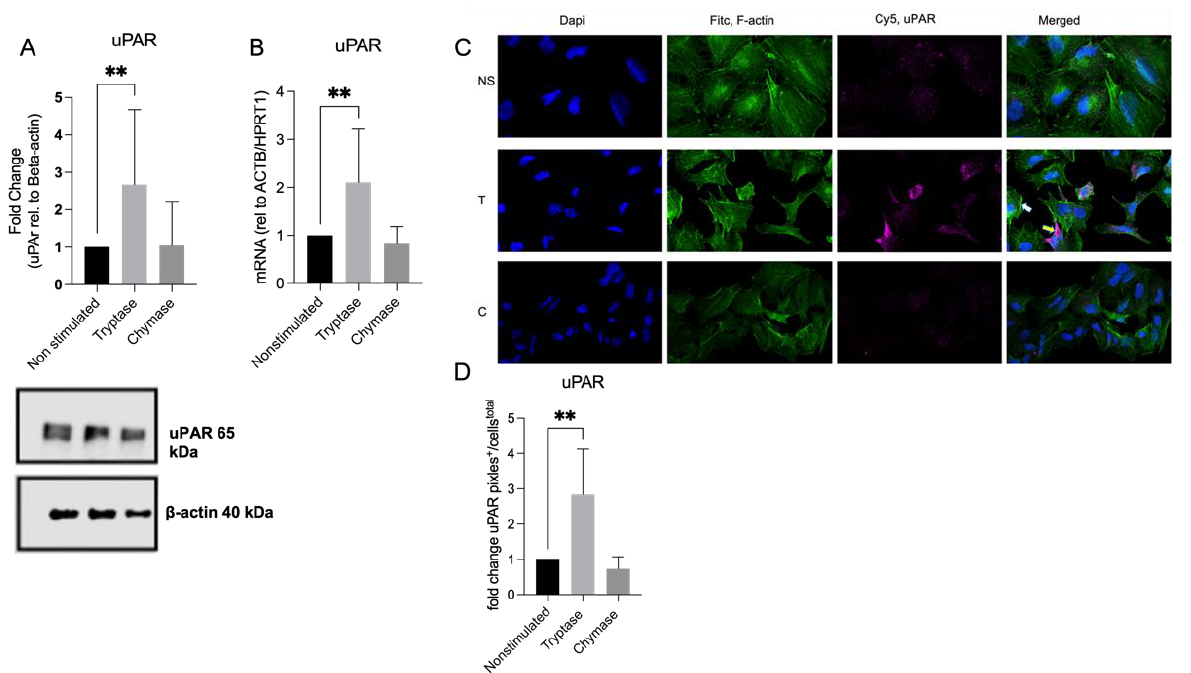
Figure 3. Cell lysates analyzed with Western blot and results based on quantification of fold change. Tryptase stimulated cells augmented the expression of uPAR (65 kDA) on protein level compared to non-stimulated cells ( A ). Tryptase stimulated cells enhanced the expression of uPAR on gene level ( B ). Double staining visualized with confocal microscopy of alveolar epithelial cells targeting F-actin (FITC/green) and uPAR (Cy5/Purple) revealed a stronger signal of uPAR ( C , D ) and a preference of a localization in a migratory direction (not quantified) in tryptase stimulated cells (yellow arrow) compared to non-stimulated cells. Statistical significance between non-stimulated and tryptase stimulated cell was tested using the Mann–Whitney test. ** p < 0.01. Data represent mean (SD) and a minimum of three technical repeats was used for quantified data.